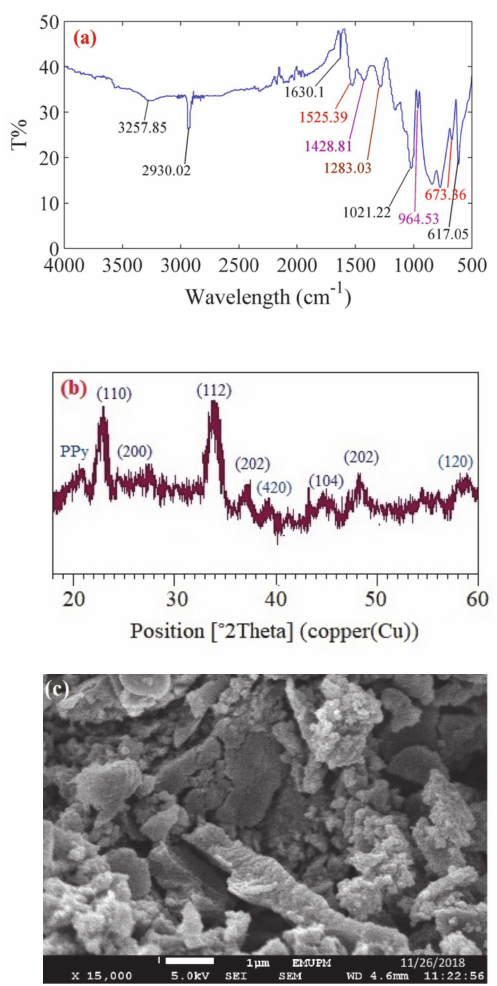
Figure 2. ( a ) The Fourier transform infrared spectroscopy (FT-IR) spectrum, ( b ) XRD result, and ( c ) FE-SEM